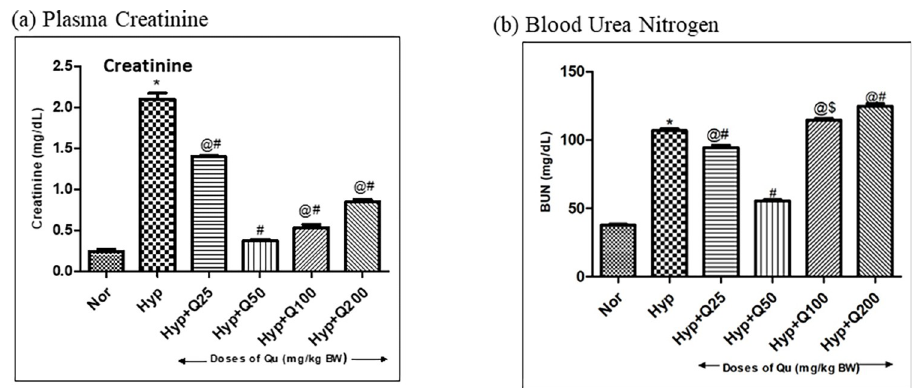
Fig 7. Effect of different doses of quercetin (25mg, 50mg, 100mg, 200mg/Kg BW) supplementation to rats exposed to 7,620m for 12h at 25 ± 2˚c on (a) Plasma Creatinine levels � p < 0.001 Norm v/s Hypo; #p < 0.001 Hypo v/s Hypo+Q25mg, Hypo+ Q50mg, Hypo+ Q100mg and Hypo+ Q200mg; @p < 0.001 Hypo+ Q50mg v/s Hypo + Q25mg, Hypo+ Q100mg, and Hypo+ Q200mg (b) Plasma BUN levels � p < 0.001 Norm v/s Hypo; #p < 0.001 Hypo v/s Hypo+ Q25mg, Hypo+ Q50mg and Hypo+ Q200mg; $p < 0.1 Hypo v/s Hypo+Q100mg, @p < 0.001 Hypo+ Q50mg v/s Hypo+ Q25mg, Hypo+ Q100mg, Hypo+ Q200 mg) levels in rats exposed to hypoxia. Norm- Normoxia control, Hypo- Hypobaric hypoxia exposure of 12h and Q25, Q 100 and Q200 mg- Quercetin @ 25, 50, 100 and 200 mg/Kg BW.